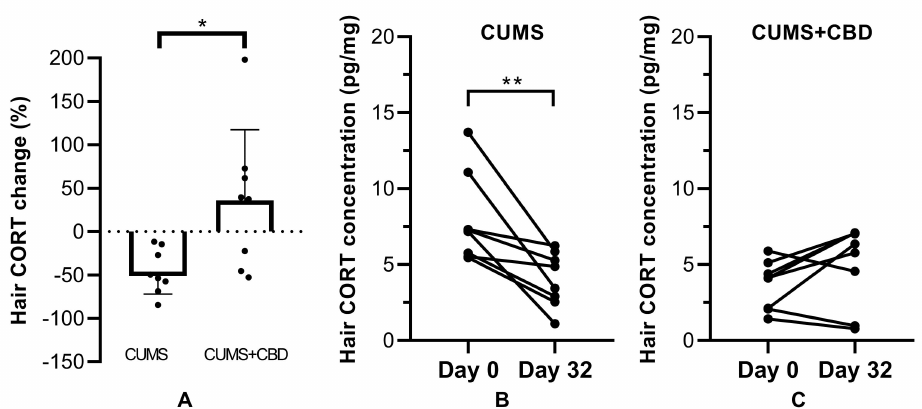
Figure 6. Hair corticosterone (CORT) levels in rats subjected to a four-week CUMS procedure and CBD treatment (10 mg / kg body weight) for 32 days. Samples were taken at day 0 and at day 32 (before and after CUMS). Means ± SEM (n = 8–10 per group) are presented. Data were analyzed by two-way ANOVA with repeated measures for the factors time and treatment. ( A ) Hair corticosterone change expressed as percentage with respect to baseline value; ( B , C ) hair corticosterone levels before and after CUMS. The dots represent individual values; * p < 0.05, ** p <